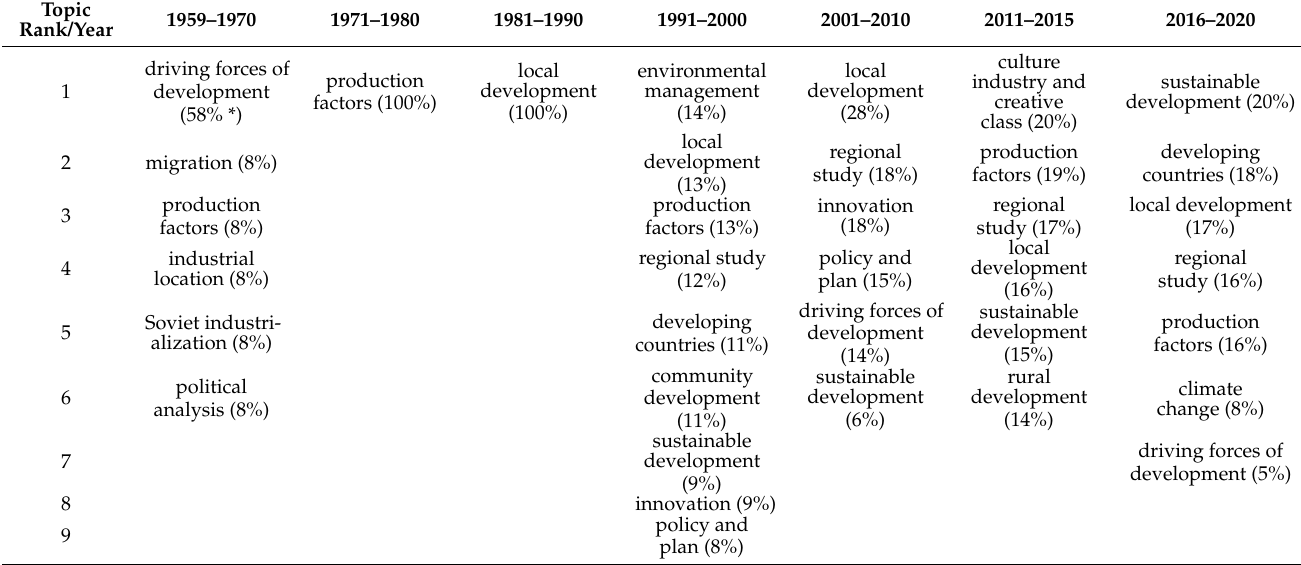
Table 2. Main topics over